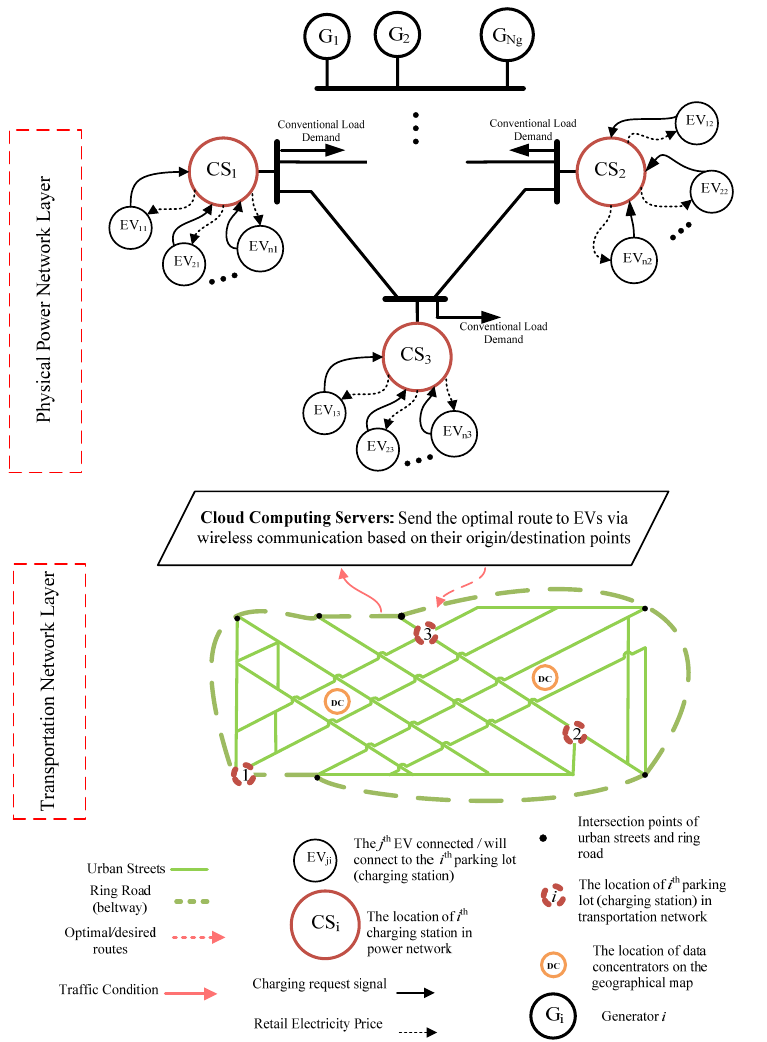
Figure 3. Schematic view of the proposed framework for the optimal operation of transportation and power